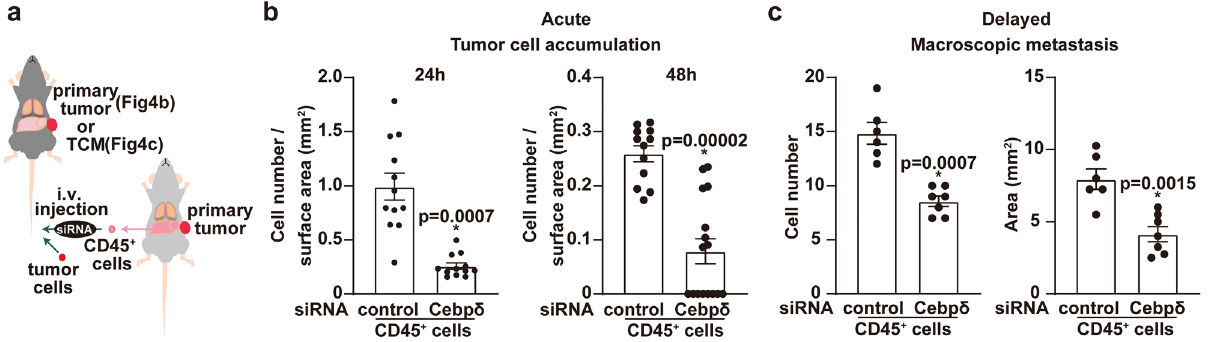
Figure 4. Reduction of lung metastasis by CEBPδ-siRNA-treated liver CD45 + cells in tumor-bearing mice. ( a ) Experimental scheme of the intravenous (i.v.) injection of tumor cells into tumor-bearing mice ( b ) and TCM- stimulated mice ( c ). ( b ) E0771 cell homing after injection of siRNA-treated tumor-bearing liver CD45 + cells. Numbers of tumor cells in lungs 24 h (left) and 48 h (right) after tumor cell injection into tumor-bearing WT mice. N = 6, (two lobes in each group). ( c ) Number of macroscopic metastatic nodules three weeks after siRNA- treated tumor-bearing liver CD45 + cell treatment followed by injection of tumor cells into tumor-conditioned medium (TCM)-stimulated mice. N = 6–7. Error bars represent the mean ± SEM, and P values (significant) are shown in graphs ( a , b